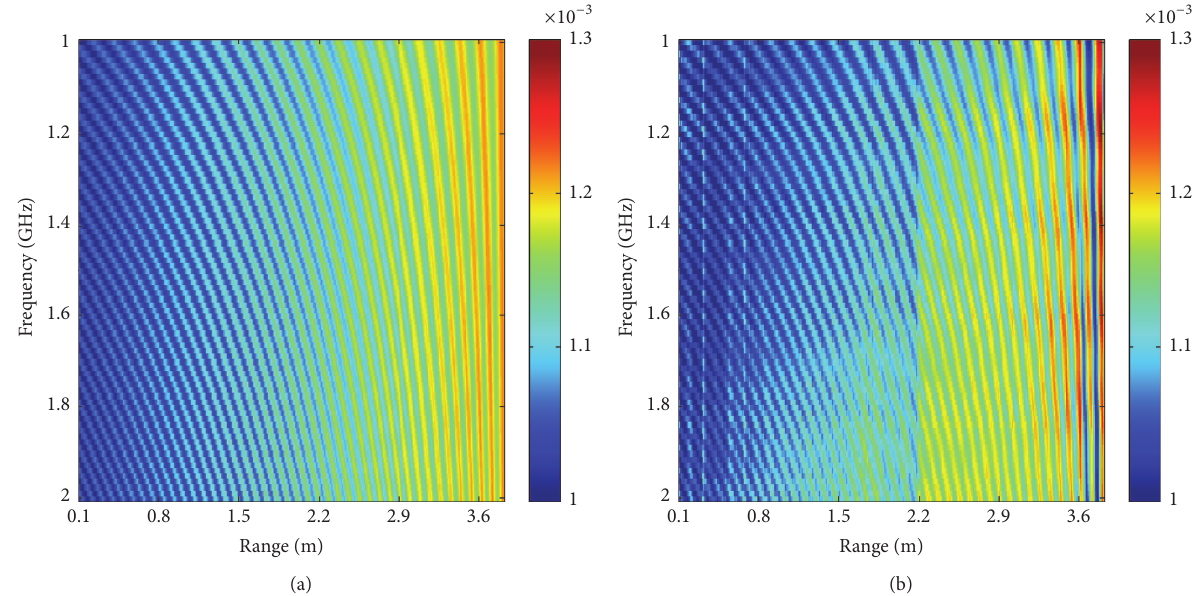
Figure 9: Amplitudes of the currents. (a) Simulated currents; (b) real